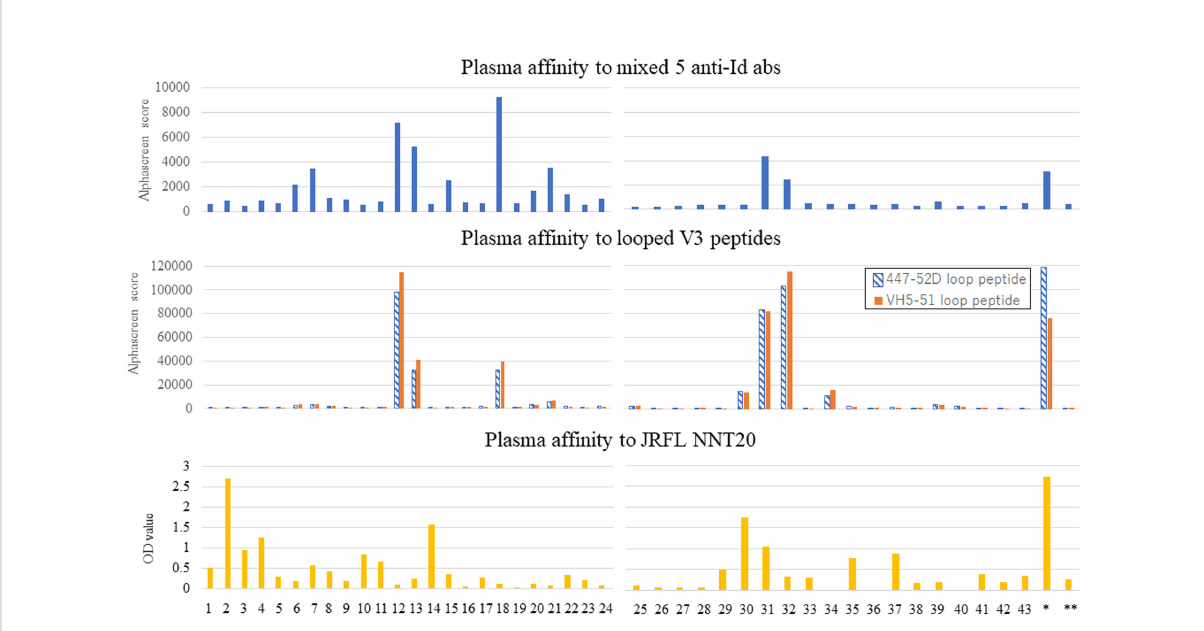
FIGURE 8 Af fi nity of 44 patients ’ plasma to anti-Id abs correlated to that to looped V3 peptides. Plasma samples from 44 HIV-positive patients were collected to investigate the binding of IgG in sera to a mixture of the fi ve anti-Id abs, the looped V3 peptides (447-52D and VH5-51), and a linear V3 peptide (JRFL NNT20). The former two af fi nities were examined by AlphaScreen, and the latter af fi nity was shown by